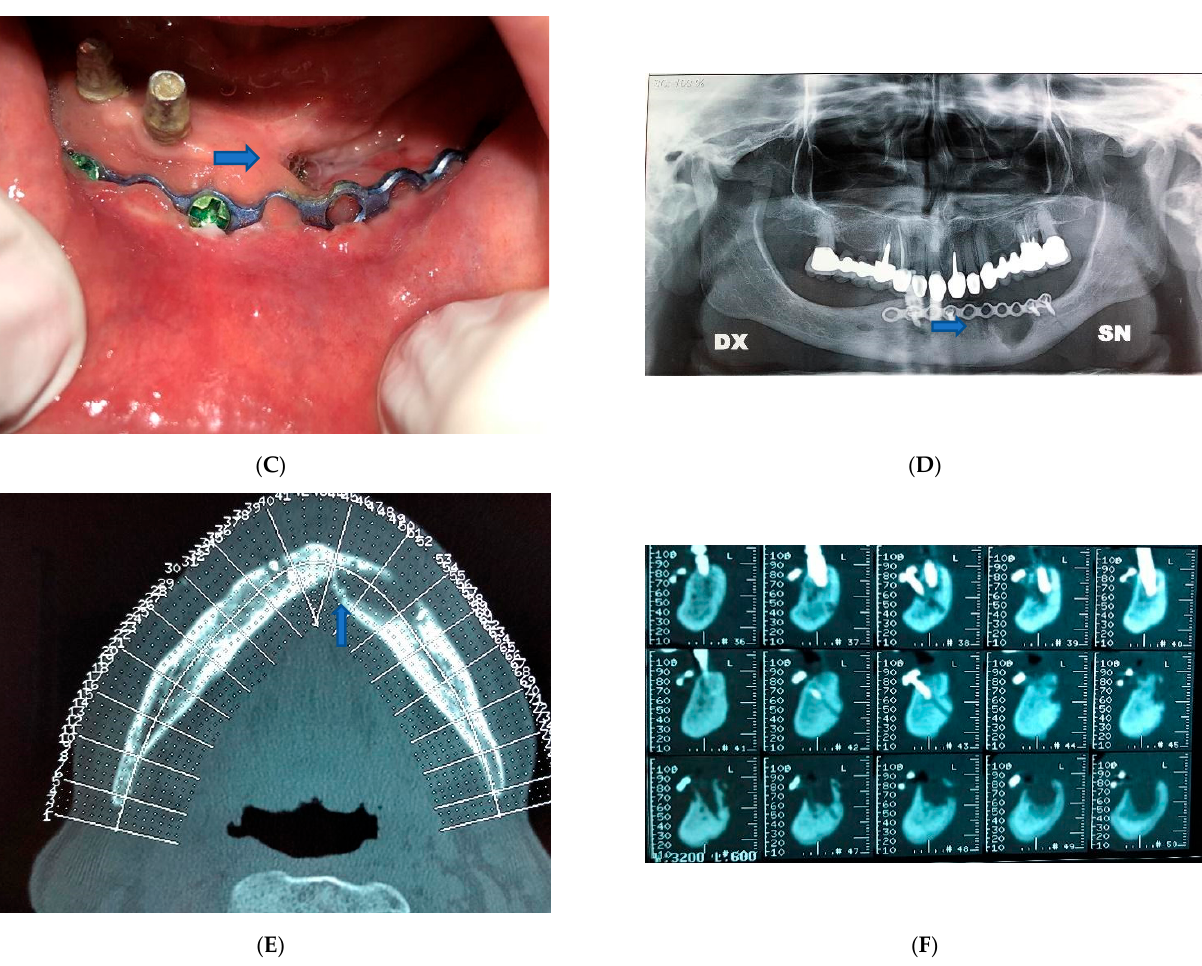
Figure 2. Patient 2. ( A ) Pre-operative panoramic X-ray examination showed no fractures, but there was a subversion of the normal organization of the bone. ( B ) Pre-operative X-Ray image showed lithic area in the lower branch. ( C ) Epi-mucosal fixation performed using SMART Lock screws and plates without elevating the mucoperiosteal flap. ( D ) Post-operative panoramic X-ray image of the dental branch revealed lithic area. ( E ) Post-operative CT scan Image. ( F ) Post-operative X-ray image.